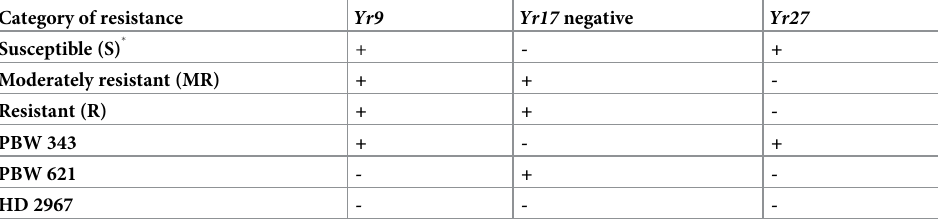
Table 4. Amplification pattern of markers of genes Yr9 , Yr17 negative and Yr27 applied on different categories of resistant selected from population of cross PBW 621 × PBW 343. Category of resistance Yr9 Yr17 negative Yr27 Susceptible (S) � + - + Moderately resistant (MR) + + - Resistant (R) + + - PBW 343 + - + PBW 621 - + - HD 2967 - - - � DNA was taken from single plant representing each category i.e., Susceptible (S), Moderately Resistant (MR) and Resistant (R) of cross PBW 621 × PBW